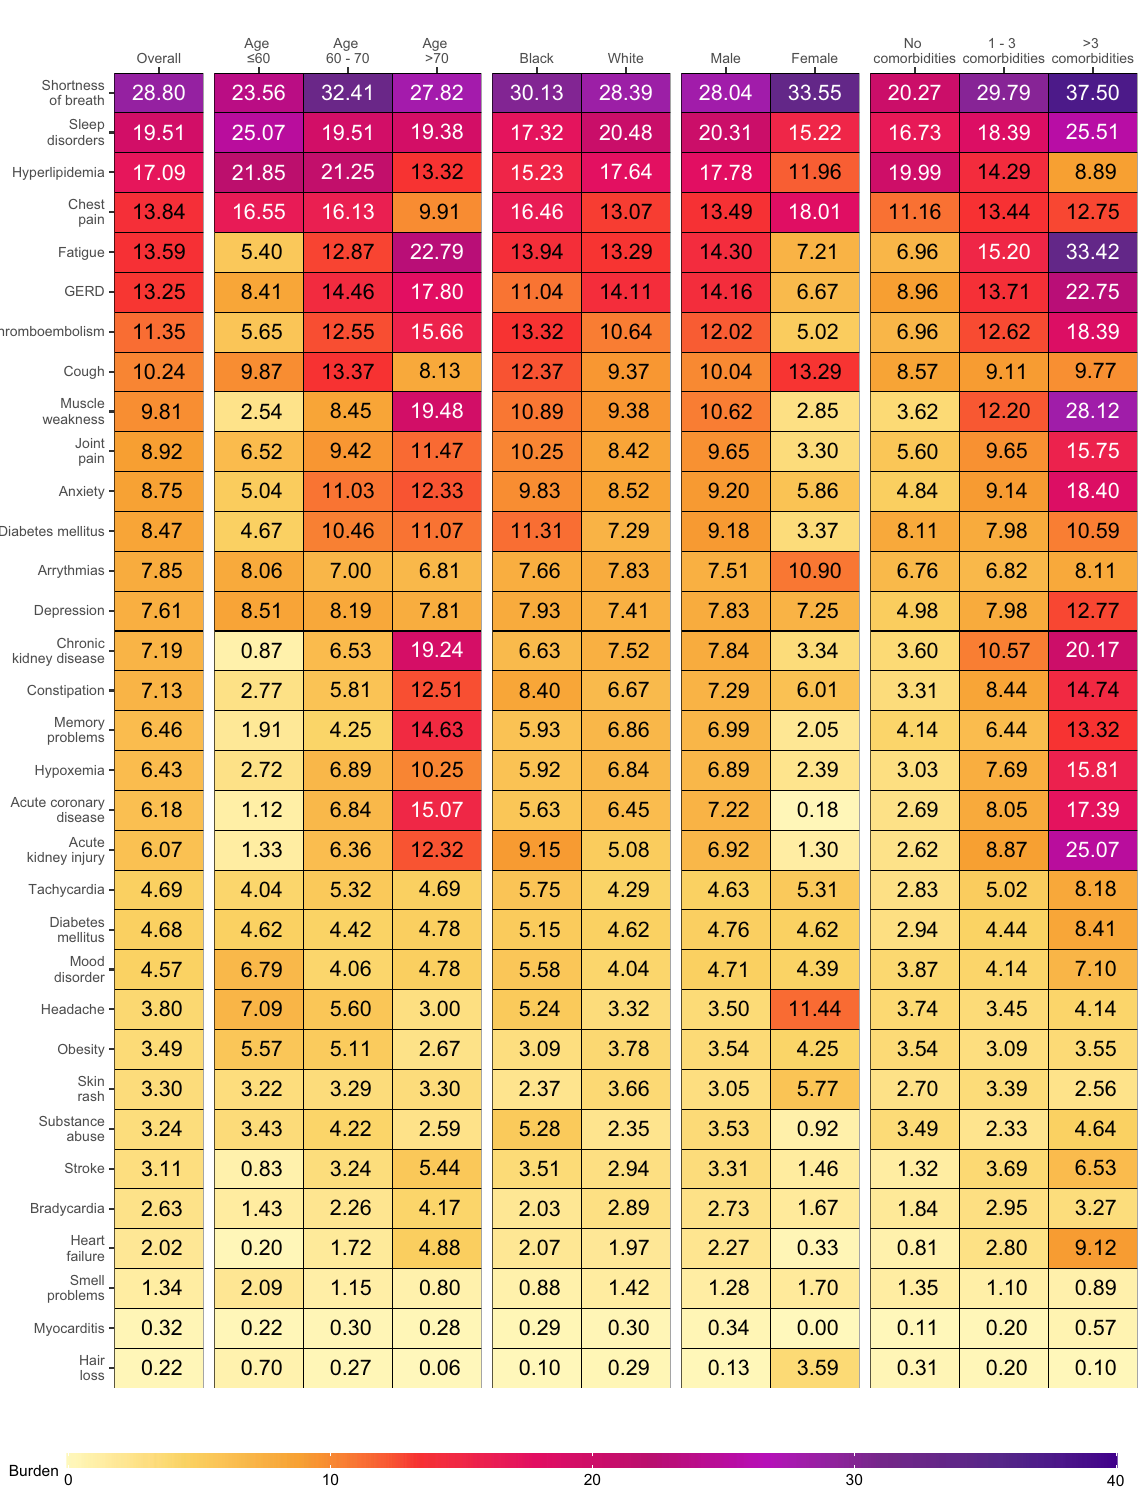
Fig. 3 Burden of post-acute sequelae of COVID-19 in the overall cohort and by age, race, sex, and health status. Post-acute sequelae were ascertained from 30 days after infection until the end of follow-up. Estimates of burdens per 1000 COVID-19 patients at 6 months are presented. Models were adjusted for age, race, sex, receipt of long-term care, Area Deprivation Index, number of outpatient encounters, number of hospital admissions, number of outpatient prescriptions, number of outpatient serum creatinine measurements, chronic lung disease, cancer, cardiovascular disease, cerebrovascular disease, dementia, diabetes mellitus, hypertension, hyperlipidemia, depression, anxiety, chronic kidney disease, hepatitis C and peripheral artery disease, overweight, obesity, smoking status, Charlson Comorbidity Index, US geographic region, total number of beds, number of COVID-19 tests administered, COVID-19 positivity rate, and average hospital bed occupancy during the week of participant enrollment when